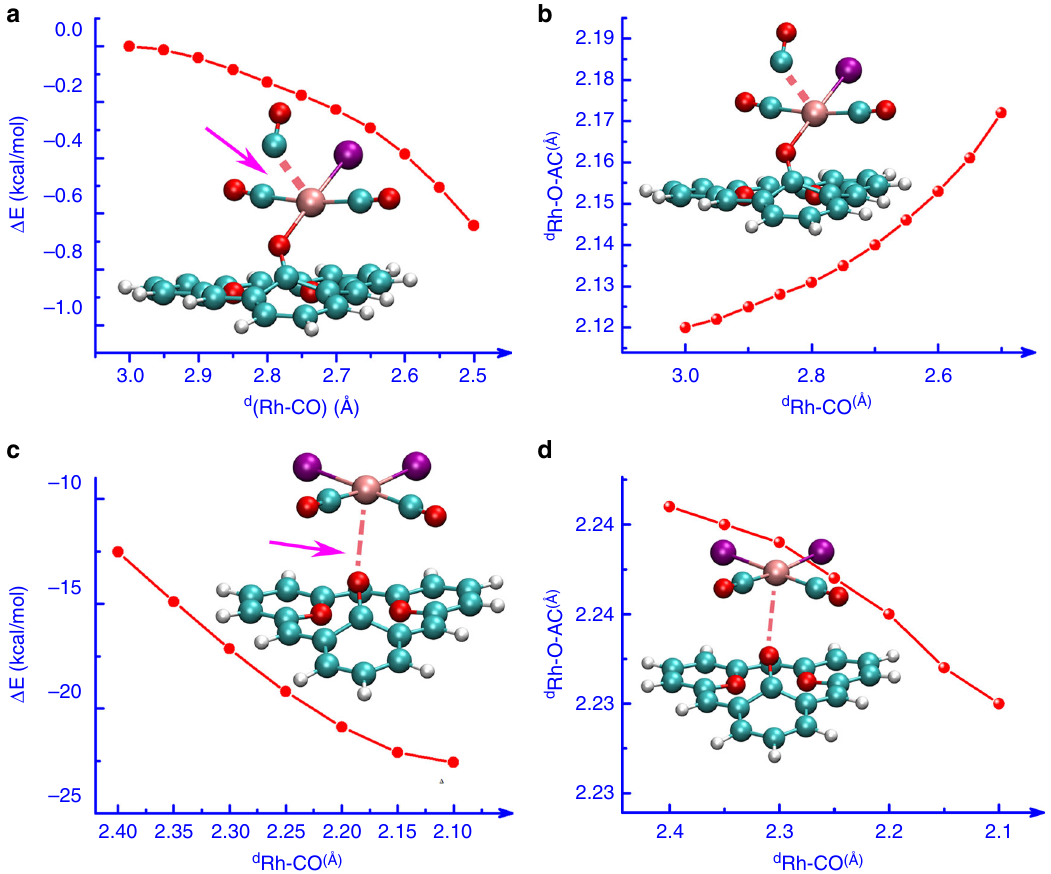
Fig. 4 Dynamic simulation of Rh(CO) 2 I(O – AC) migration and transformation. a , b Variation of energy and Rh – O – AC bond distance during the process of Rh(CO) 2 I(O – AC) attacked by CO. c , d Variation of energy and Rh – O – AC bond distance during the process of Rh(CO) 2 I 2 anchoring on the neighboring oxygen site in the surface of